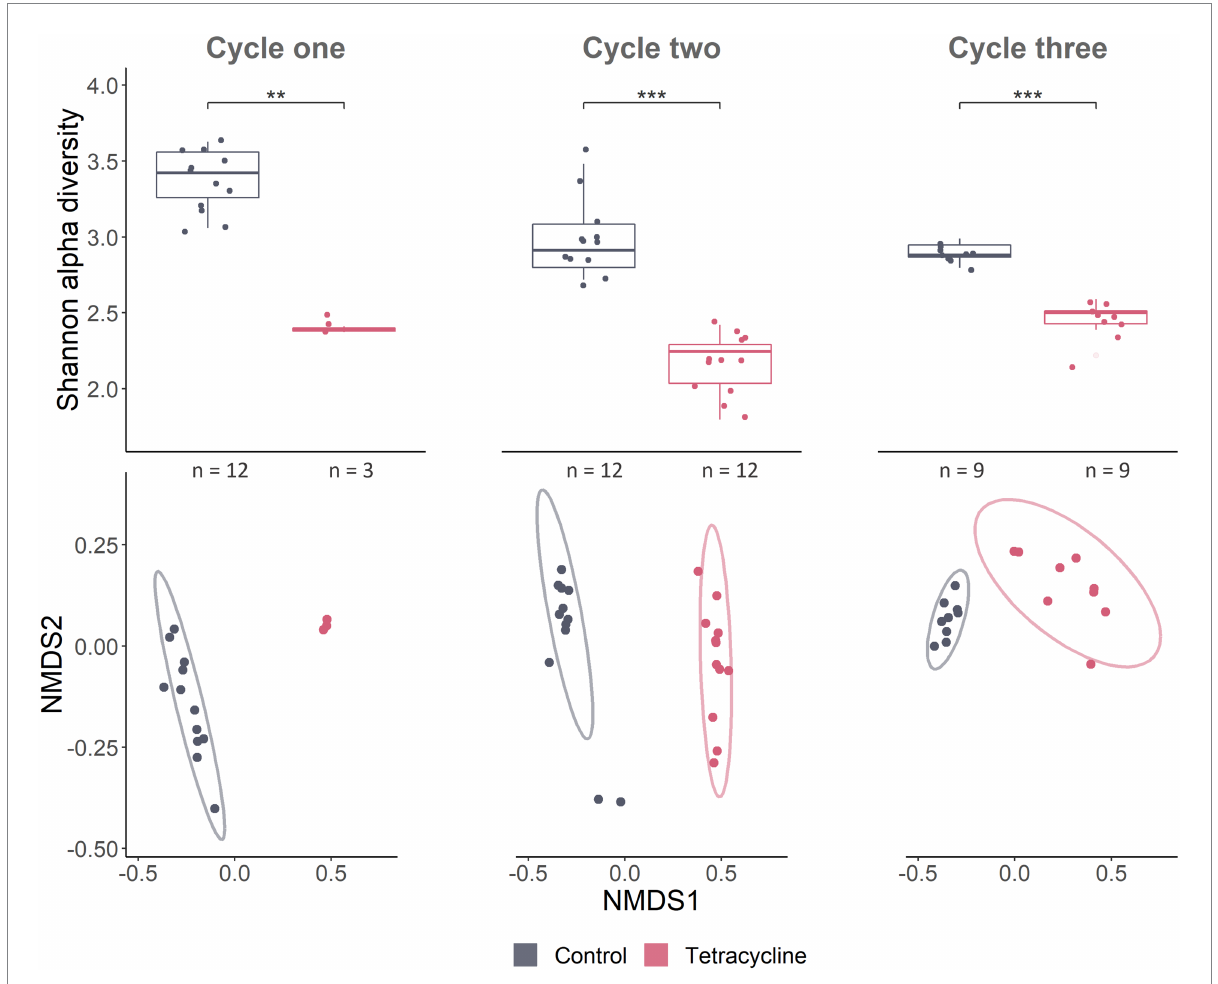
FIGURE 4 Gut microbial community composition responds to tetracycline treatment. Alpha- and beta-diversity as well as taxonomy show tetracycline leading to a strong dysbiosis, decreasing several taxa. Alpha diversity Shannon index accounts for abundance and evenness of ASV in samples. Pairwise Wilcoxon rank sum tests were used for statistical comparisons between treatments and controls (*** < p 0.001; ** < p 0.01) (cycle 1: W = 36, p = 0.004; cycle 2: W = 144, p < 0.001; cycle 3 before stress: W = 81, p < 0.001). NMDS on Bray–Curtis dissimilarity which considers presence/absence as well as abundances of ASVs, represents compositional differences between samples (beta diversity). Stress of NMDS was 0.069. Ellipses represent 95% confidence intervals around treatment